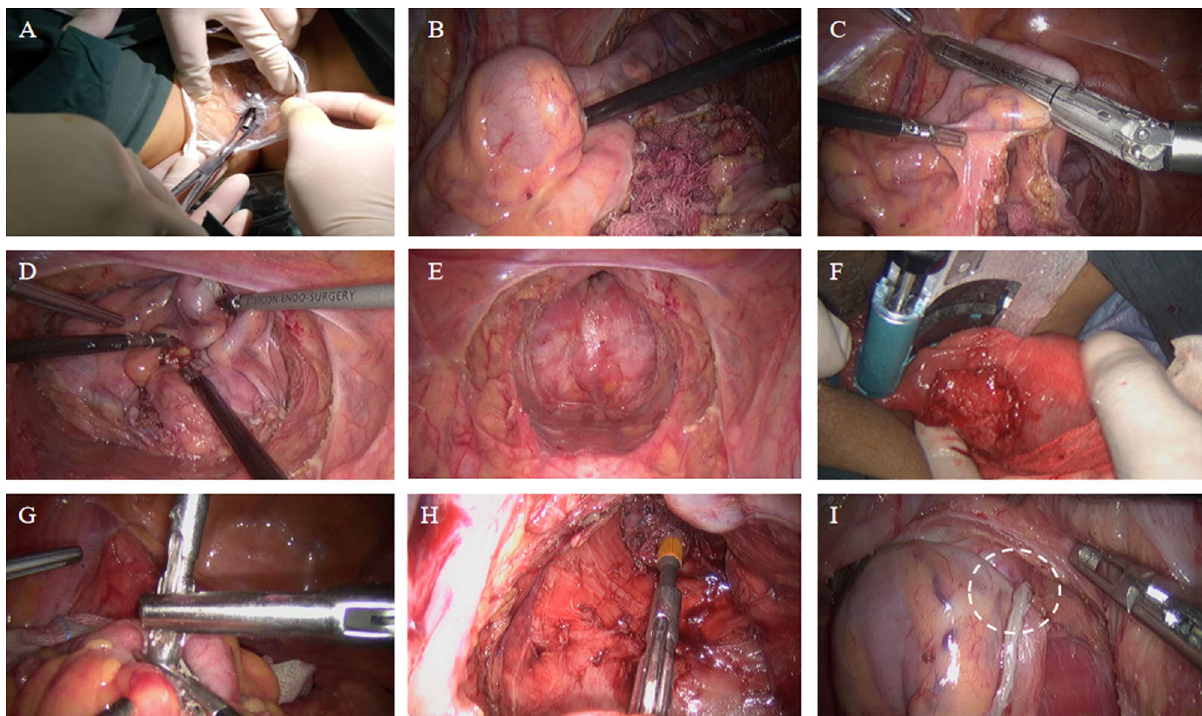
Figure 3. Disconnection and removal of specimens of the NOSES group. ( A ) Insert the sterile plastic protective sleeve through the anus to the top of the tumor 5 cm, and insert it into the anvil through the anus. ( B ) The anvil is delivered into the sigmoid colon. ( C ) The division of sigmoid colon is performed. ( D ) The specimen is extracted from anus. ( E ) Display of the pelvic after specimen extraction. ( F ) Use the Kaitu closure to cut the rectum at 1–2 cm below the tumor edge. ( G ) Remove the anvil connection rod at the broken end of the sigmoid colon. ( H ) Complete sigmoid rectal end-to-end anastomosis. ( I ) “Risk and sigmoid colon are freed and the intestine below the tumor is shrunk. Finally, the NOSES group and the CLR group used different methods to perform specimen removal and digestive tract reconstruction. In the CLR group, the specimen was taken through an auxiliary incision below the navel. And then the end- to-end anastomosis of the sigmoid colon and rectum is performed. Finally, the abdominal cavity was irrigated with sterile distilled water and normal saline, and the incision and the trocar hole were closed. In the NOSES group, followed by gentle dilation of anal canal, the sterile plastic sleeve is inserted into the rectum, certifying that the upper edge of sleeve should be more than 5 cm above the upper edge of tumor. The anvil is then introduced into the bowel lumen through the sleeve, toward the proposed resection line of sigmoid colon (Fig. 3A,B). Proximal bowel division is performed through the right lower quadrant cannula using the 60 mm straight linear stapler (Fig. 3C), leaving the anvil inside of sigmoid colon. Povidone gauze is used to dis- infect both sides of stumps. A large clamp is reintroduced into the bowel lumen through the anal canal to grab the rectal stump and to gently drag it out extracorporeally (Fig. 3D,E). The reverse rectal specimen is flushed extraabdominally with 1% povidone-iodine. The distal rectal resection is performed extraabdominally using the curved cutter stapler, making sure to preserve 1–2 cm of lower tumor margin, and the specimen is then removed (Fig. 3F). The rectal stump is then delivered back to pelvic cavity. Following the rectal dilation, the rectal irriga- tion is performed by using the 1% povidone-iodine. Then, the center rod of the anvil head is extracted from the proximal bowel lumen (Fig. 3G). The circular stapler is introduced transanally, and an end-to-end anastomosis is then performed with a great care, to certify the surrounding tissues not being caught in the anastomotic site (Fig. 3H,I). We recommend routine use of two drainage tubes near the anastomotic area in the pelvic cavity. For rectal cancer patients who undergo the ultra-low anastomosis surgery, the anastomosis should be firmly sutured extraabdominally. Finally, the abdominal cavity was irrigated with sterile distilled water and normal saline, and the trocar hole was closed. Data collection and follow‑up. Data collection. In this study, all basic and treatment-related informa- tion of the patients was obtained from the medical record system of the Second Affiliated Hospital of Harbin Medical University. Patients were considered to have incision-related complications if their incision showed bleeding, fever, infection and fat liquefaction between 1 day and 2 weeks postoperatively, or if they developed an incisional hernia within 3 months postoperatively. In this study, patients were asked to fill out a Body Image Questionnaire (BIQ, see Supplementary Material 1) at 1 month after surgery, which we used to assess attitudes toward their physical appearance and satisfaction with the appearance of the scar 16 . We also applied the PFDI-20 to assess the extent to which patients’ symptoms of lower urinary tract, lower gastrointestinal tract, and pelvic